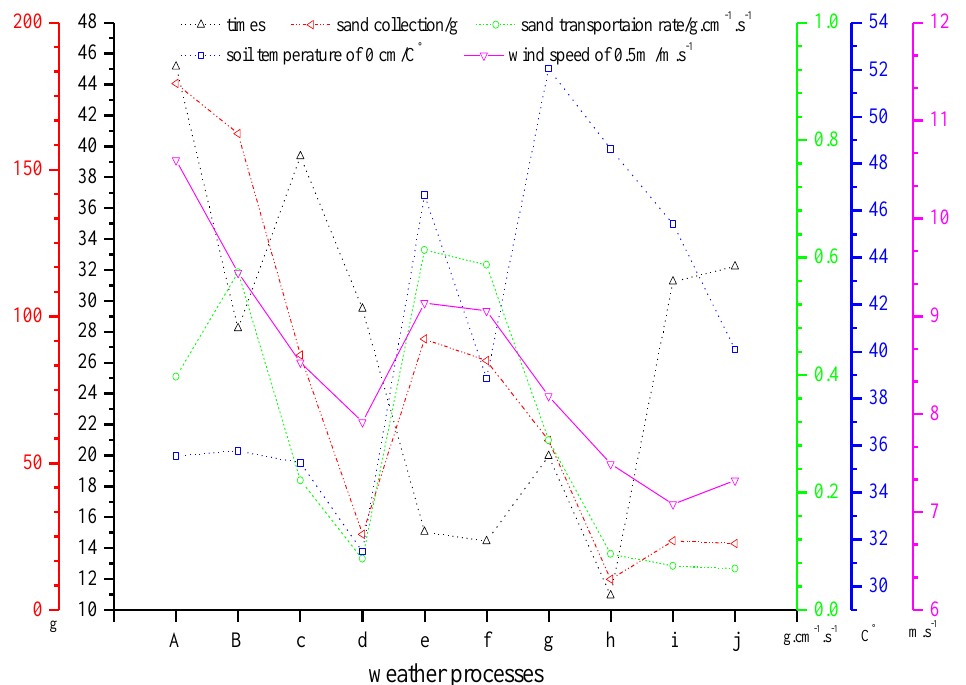
Figure 9. Sediment of different dust events.